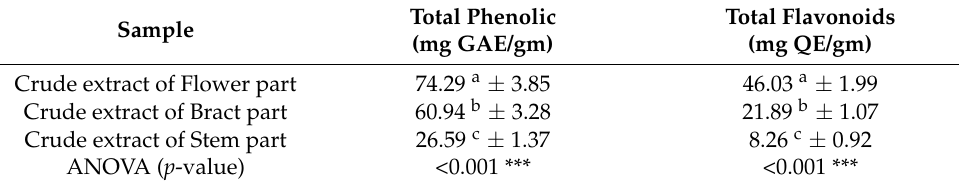
Table 2. Total phenolics and total flavonoids in flower, bract, and stem of C. scolymus L.